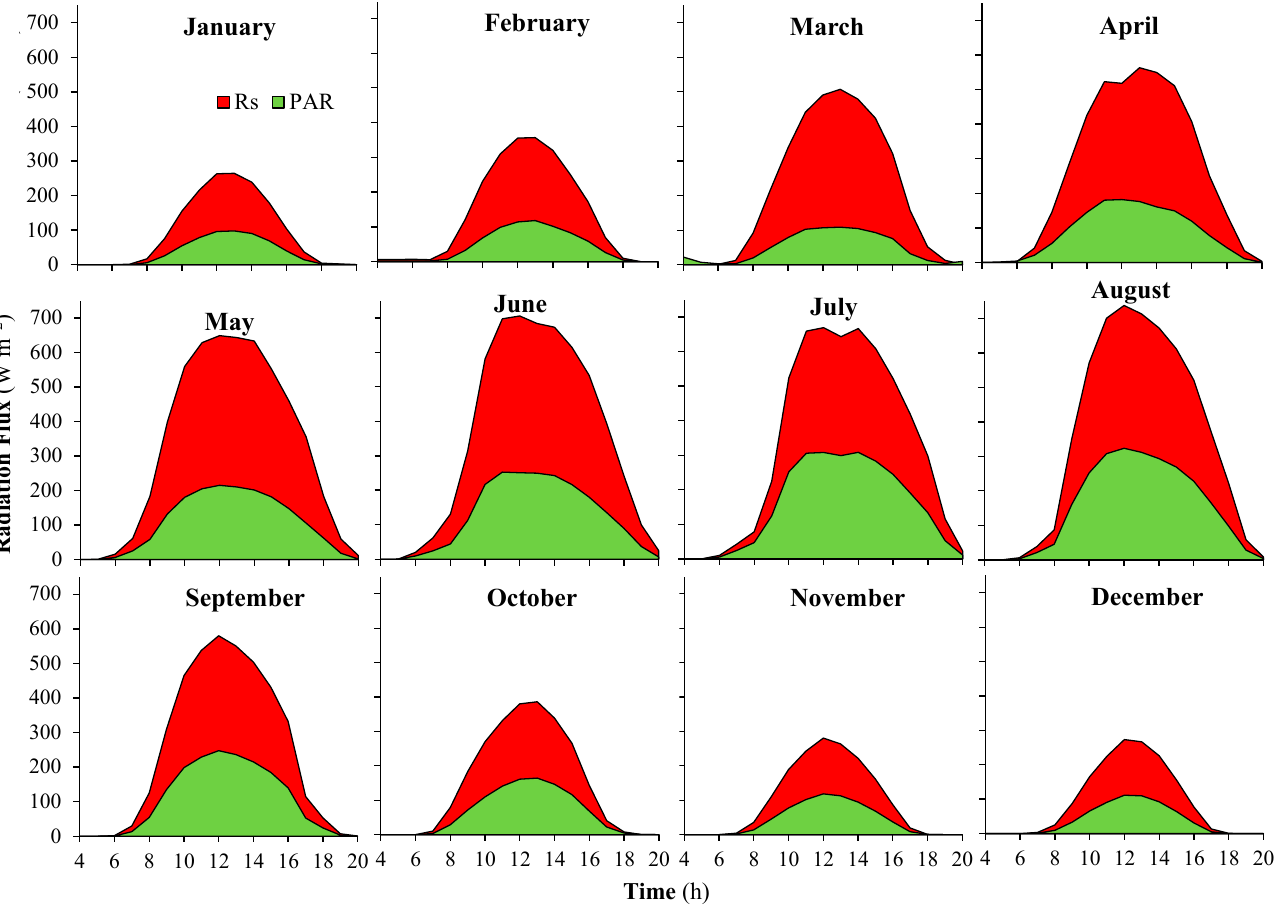
Figure 4. Diurnal variation of the PAR and Rs hourly average radiation fluxes, during the different months of the year.